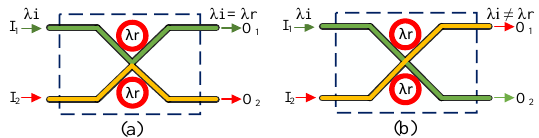
Figure 1. 2 × 2 OSE. ( a ) MR OSE drop / bar state. ( b ) MR OSE through / cross Figure 1 . 2 × 2 OSE. ( a ) MR OSE drop/bar state. ( b ) MR OSE through/cross state. Table 1. MR based 2 × 2 OSE switching state table.